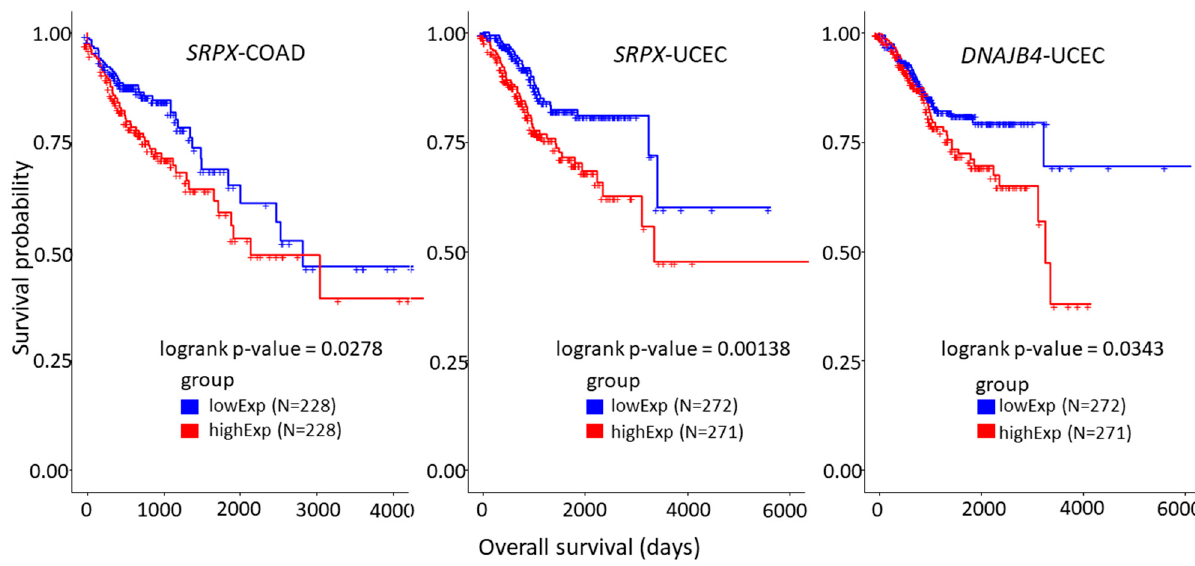
Figure 5. Kaplan–Meier (K–M) survival analysis plots for prognostic mRNAs in the shared ceRNA network of hormone-dependent (HD) cancers. The low-expressed SRPX gene exhibits prognostic ability in both colon ( left ) and endometrial ( centre ) cancer. The low-expressed DNAJB4 shows better survival in endometrial cancer ( right